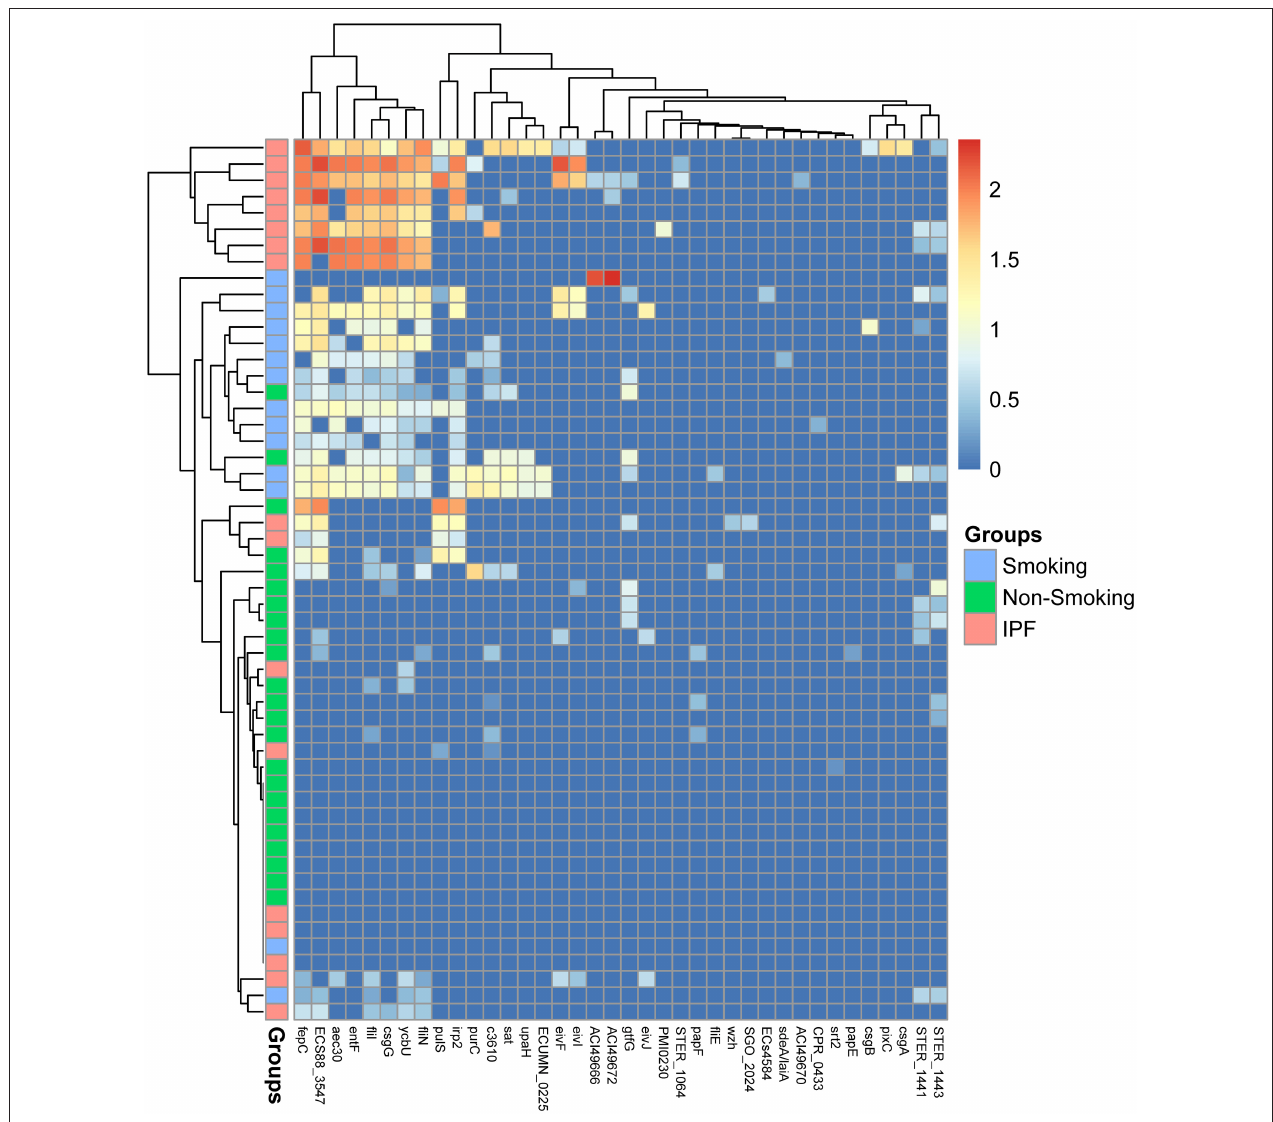
FIGURE 6 | Abundances of virulence genes from BALF samples. Each column corresponds to an individual BALF’s sample from IPF group (pink color) and healthy control group (smoking: blue color; non-smoking: green color) showed on the left side. The types of virulence factors were indicated in the boxes at the bottom. Each row corresponds to a specific abundance of virulence genes based on different colors according to different abundance